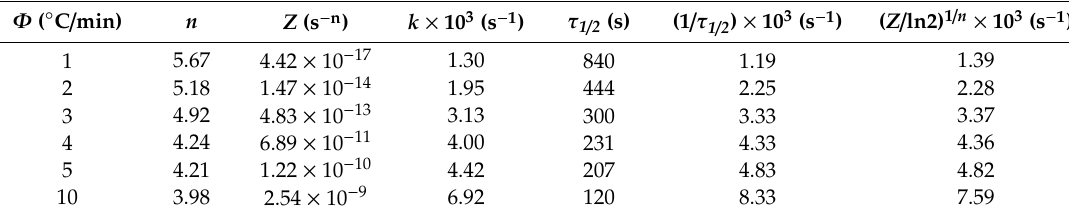
Table 1. Non-isothermal crystallization kinetic parameters deduced from di ff erential